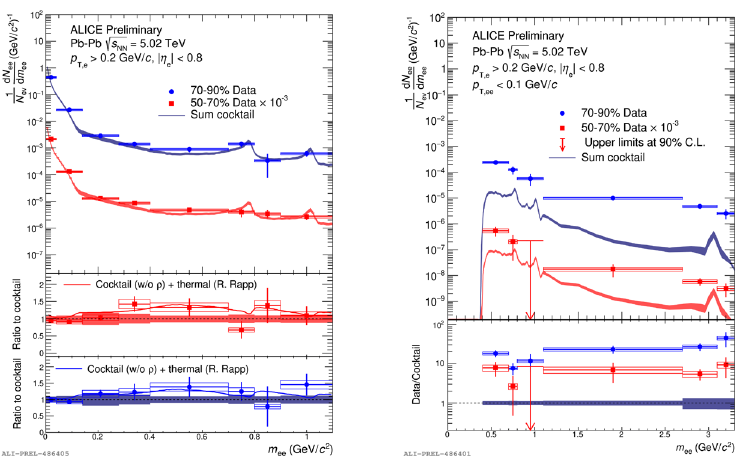
Figure 1. Left: dielectron production in pp collisions at √ s = 5.02 TeV compared to the expectations from known hadronic decays[1]. Right: dielectron nuclear modification factor in p–Pb collisions at = 5.02TeV compared to calculations[1]. √ s NN Figure 2. Dielectron yields in semi-peripheral (50-70%) and peripheral (70-90%) Pb–Pb collisions integrated over p T , ee (left panel) and for p T , ee < 0.1 GeV / c (right panel) compared to the hadronic cocktail including or not thermal radiations.